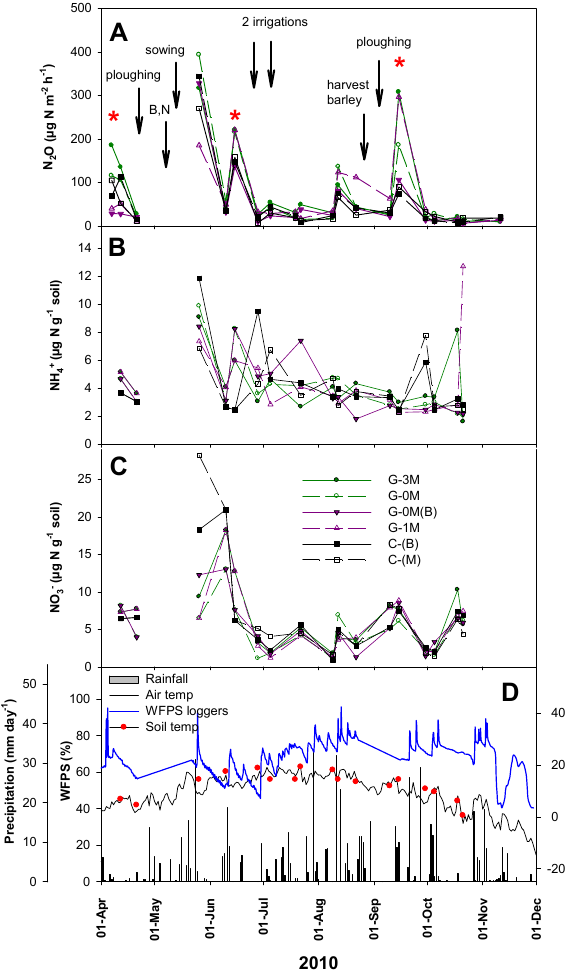
Fig. 2 Fig. 2. (A) Average N 2 O fluxes (µgNm − 2 h − 1 ) during the year of barley production (2010). Standard deviations are omitted to increase readability. Dates with significant treatment differ- ence in N 2 O emissions are marked by asterisk. (B) Soil NH + 4 (µgNg − 1 soil). (C) Soil NO − (µgNg − 1 soil). Mineral N concen- 3 trations are from one composite sample (0–20cm) per treatment on each sampling date. (D) Daily precipitation, air temperature and %WFPS and soil temperature at the time of flux measurement. WFPS is calculated from weighted mean of hourly volumetric soil moisture readings at 5 and 20cm depth. See Table 2 for treatment description. B = biogas residue, N = mineral N